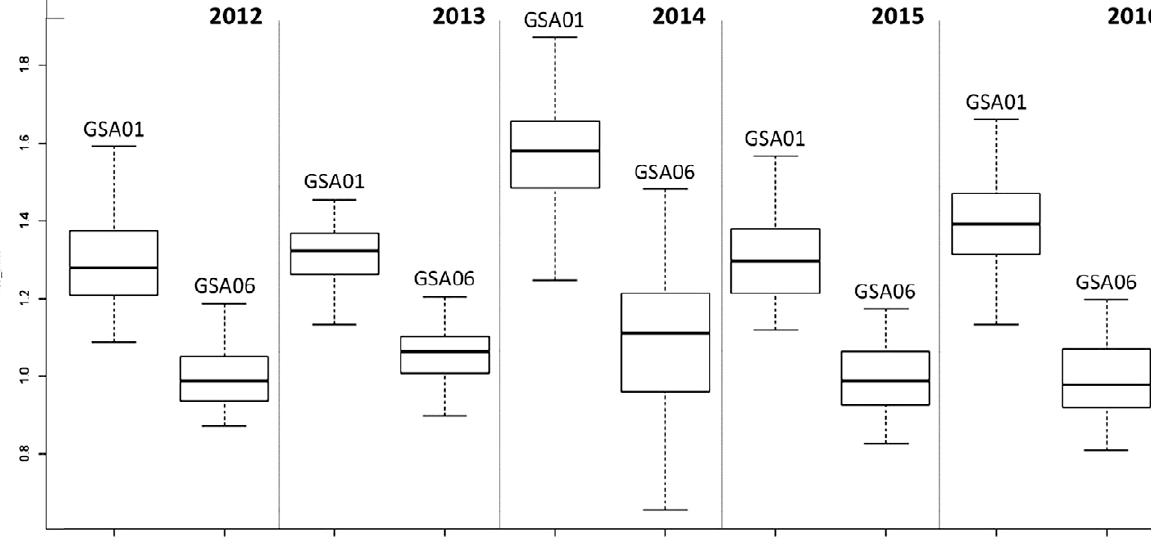
Fig. 6. – Box plot showing the first otolith radius (R1) length (mm) distribution per year and GSA. The mid-point of the data (median) is shown by the line that divides the box into two parts; the middle “box”, limited by the first quartile (Q1) and the third quartile (Q3), represents the interquartile range (IQR), and the upper and lower whiskers represent the Q1-1.5*IQR and the Q3-1.5*IQR